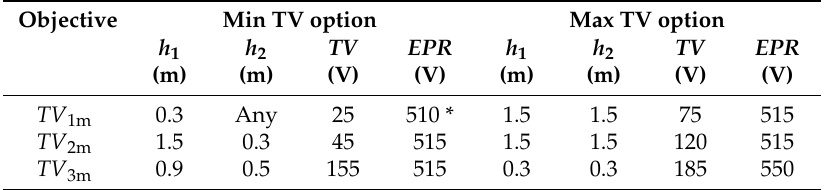
Table 4. Sensitivity analysis results for ρ 1 = 100 Ω m, ρ 2 = 500 Ω m, H = 2 m, D 2 = 4 m, D 1 = 2 m.